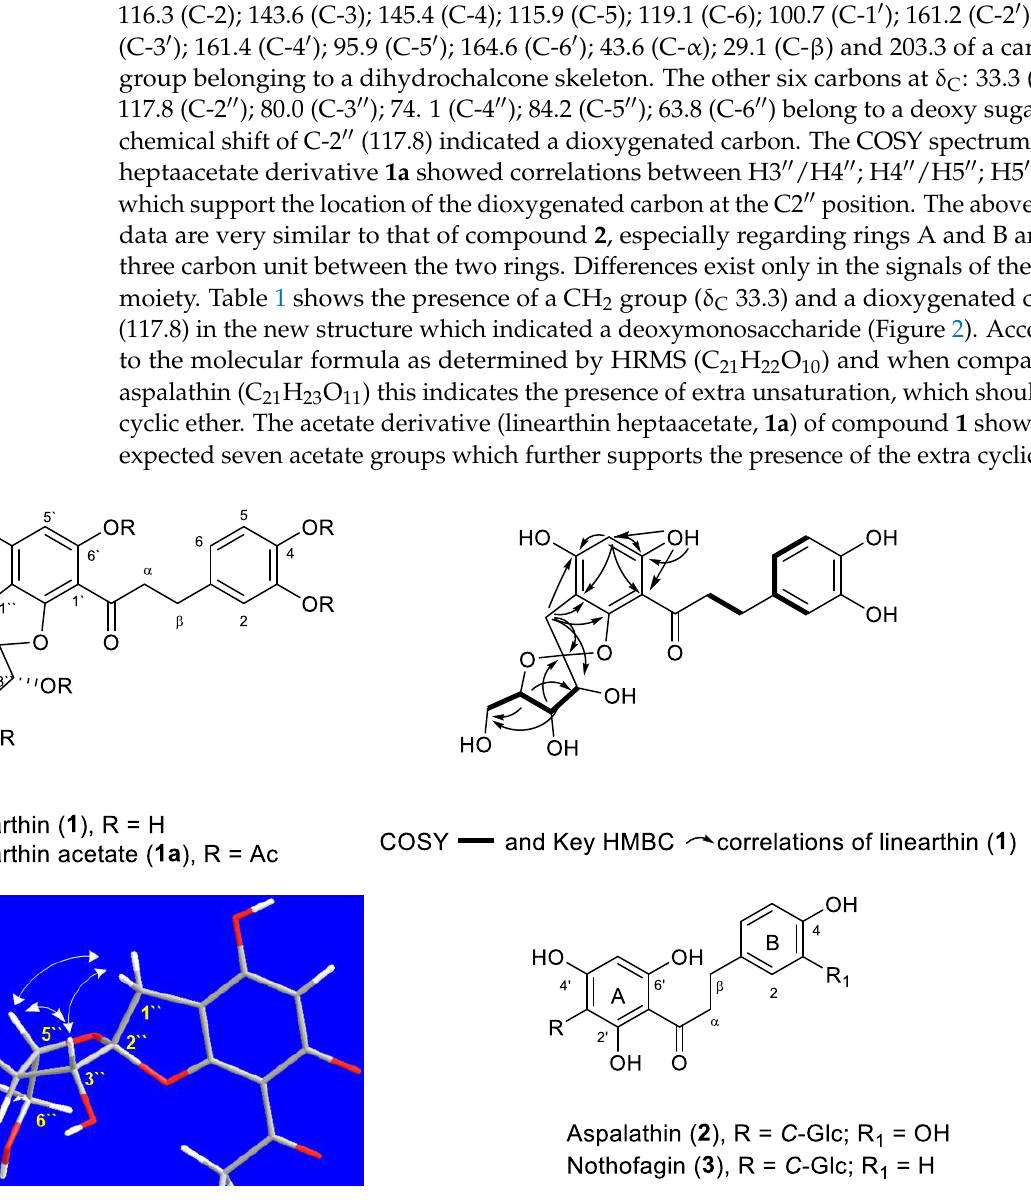
Figure 1. Chemical structure of the isolated compounds and COSY, HMBC and NOESY correlations of compound 1 .